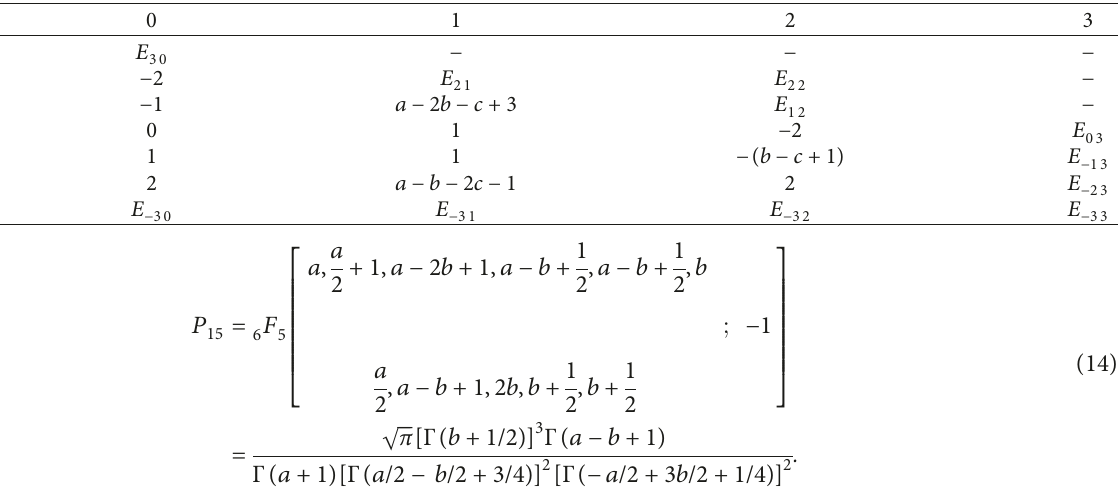
Table 5: Table for the coefficients E